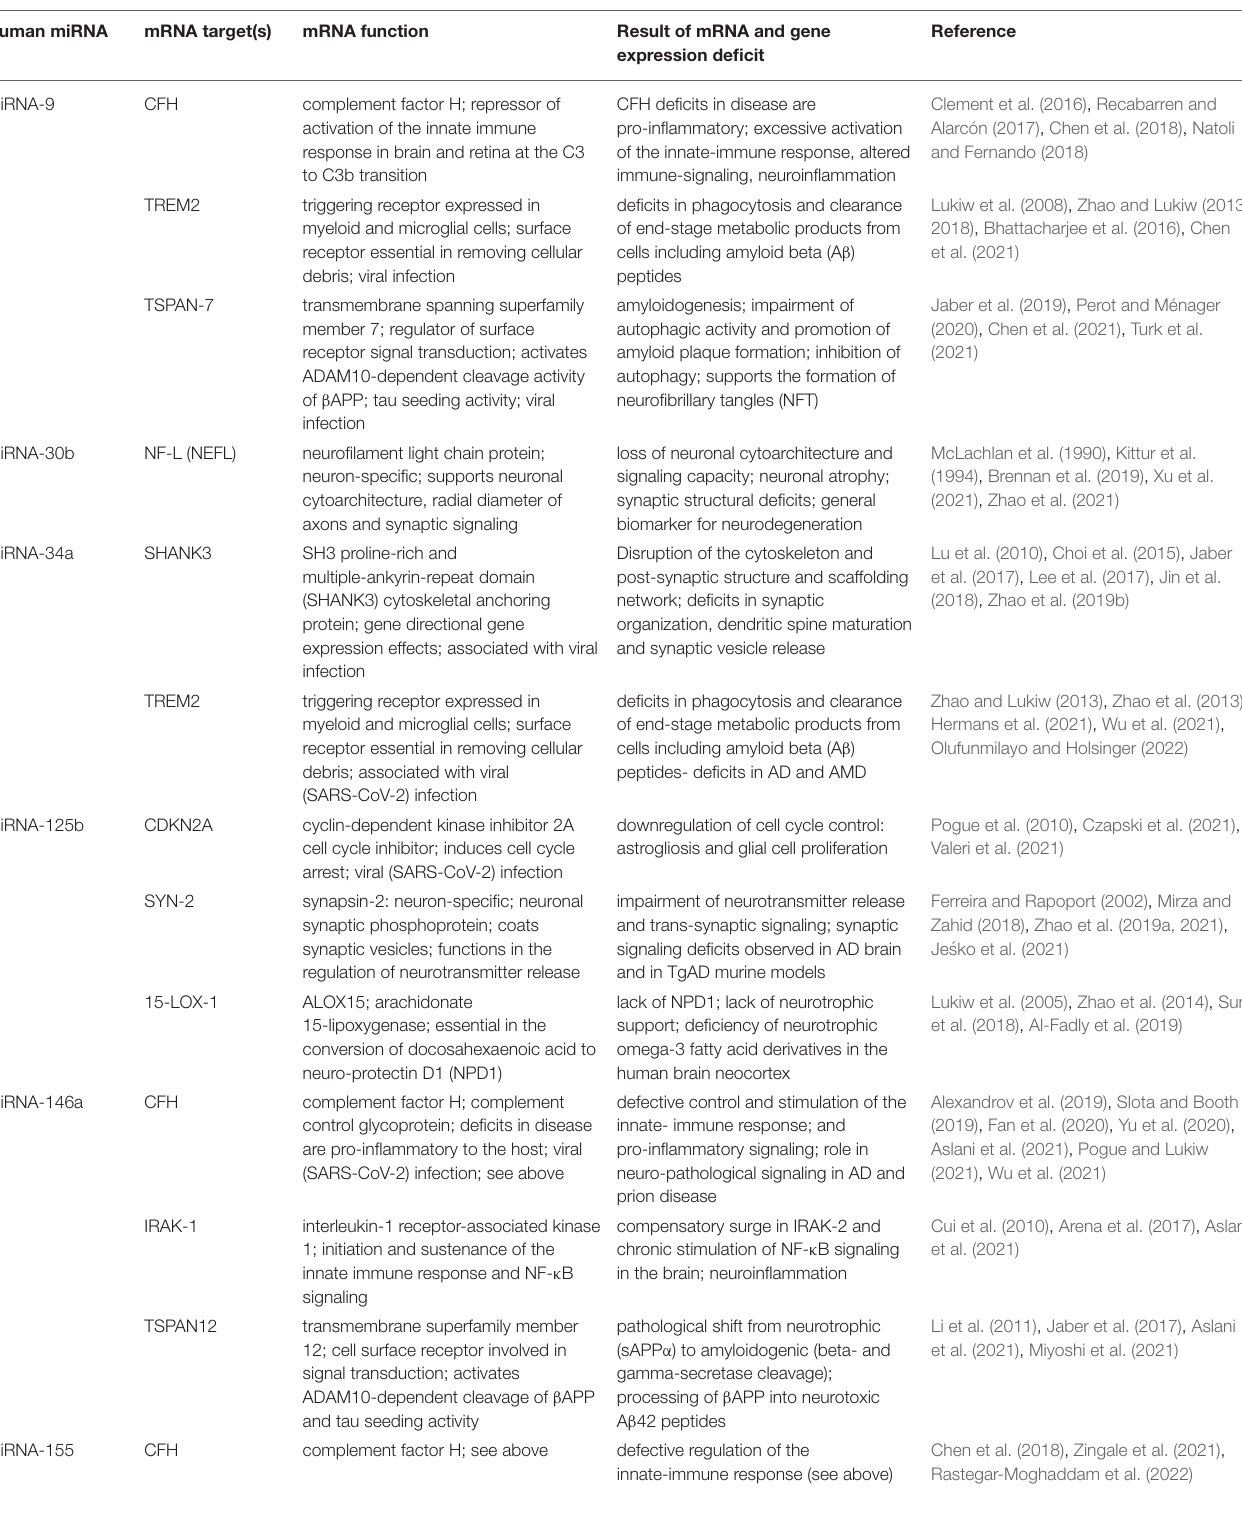
TABLE 1 | NF-kB-induced microRNAs (miRNAs), their mRNA targets, functions, and pathways in Alzheimer’s disease (AD)-affected brain; all miRNAs listed show: (i) significant upregulation following NF-kB (p50/p65) activation; (ii) are potentially pathogenic and are upregulated in AD brain, AD cell culture, and transgenic murine models of AD (TgAD); and (iii) have been shown to interactively contribute to the AD process; some closely related work on the functions these miRNAs in neuronal cell culture, TgAD models, and other human neurodegenerative diseases have also been included in the References. Human